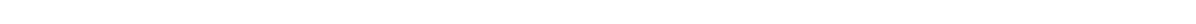
Fig. 5 TMEM55B/JIP4 drive retrograde lysosomal traf fi cking independent of RILP. a HeLa cells treated with JIP4 or Control siRNA were immunostained with antibody against LAMP-1. b Quanti fi cation of lysosome distribution shown as the percentage of total fl uorescence signal detected at 0 – 5 μ m, 5 – 15 μ m, or > 15 μ m from nuclear rim. Quanti fi ed results are presented as mean ± s.e.m. using two-tailed t -test ∗ P < 0.05, ∗∗ P < 0.005 were considered signi fi cant, n ≥ 30. c Immunoblot of HeLa cells depleted of JIP4 or Control RNAi. d HeLa cells treated with JIP4 or Control siRNA were infected with adenovirus expressing GFP-TMEM55B for 24 h. Cells were fi xed, permeabilized, and immunostained with antibodies against LAMP-1. Arrows denote bulk of lysosomal accumulation. e Quanti fi cation of lysosome distribution, percentage of total fl uorescence signal detected at 0 – 5 μ m or > 15 μ m from nuclear rim. Quanti fi ed results are presented as mean ± s.e.m. using two-tailed t -test ∗ P < 0.05, ∗∗ P < 0.005 were considered signi fi cant, n ≥ 10. f HeLa cells depleted of TMEM55B, JIP4, or expressing control RNAis were transfected with GFP-RILP for 24 h. Cells were fi xed, permeabilized, and immunostained with antibodies against LAMP-1. Arrows denote bulk of lysosomal accumulation. Scale bars, 20 μ